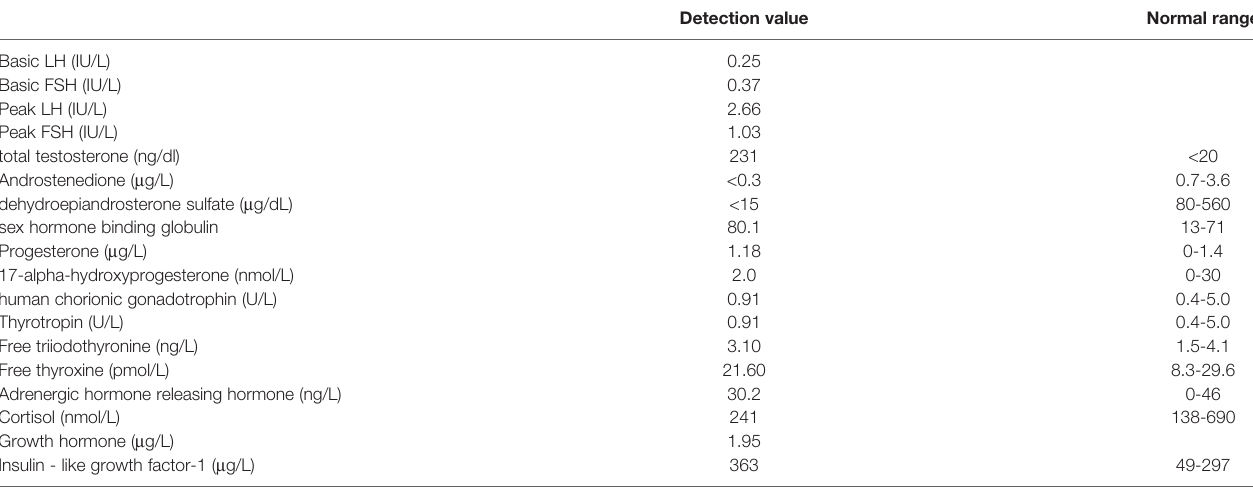
TABLE 1 | Hormonal features of the patient with testotoxicosis at diagnosis.